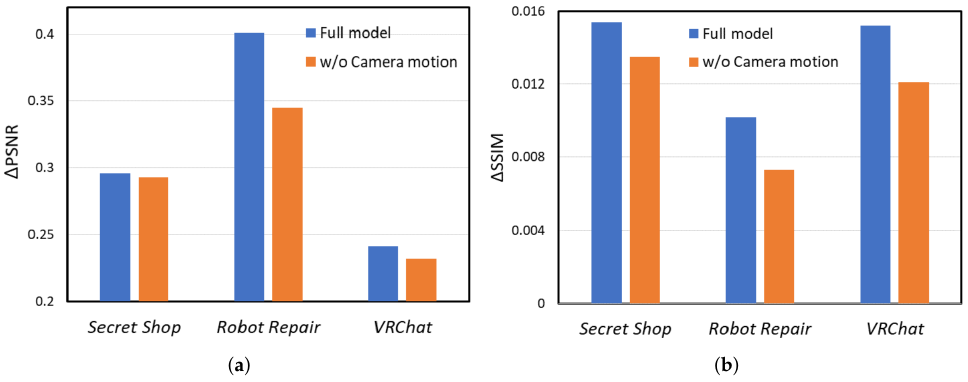
Figure 8. Quality enhancement difference under QP = 37. ( a ) ∆ PSNR. ( b ) ∆ SSIM.